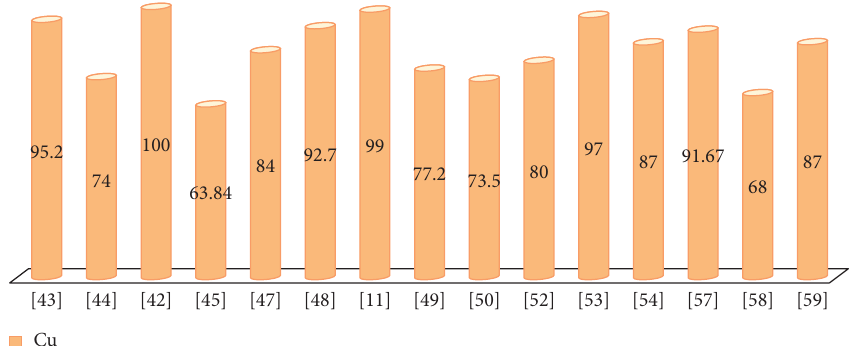
Figure 4: Graphical representation of copper recovery from previous studies.